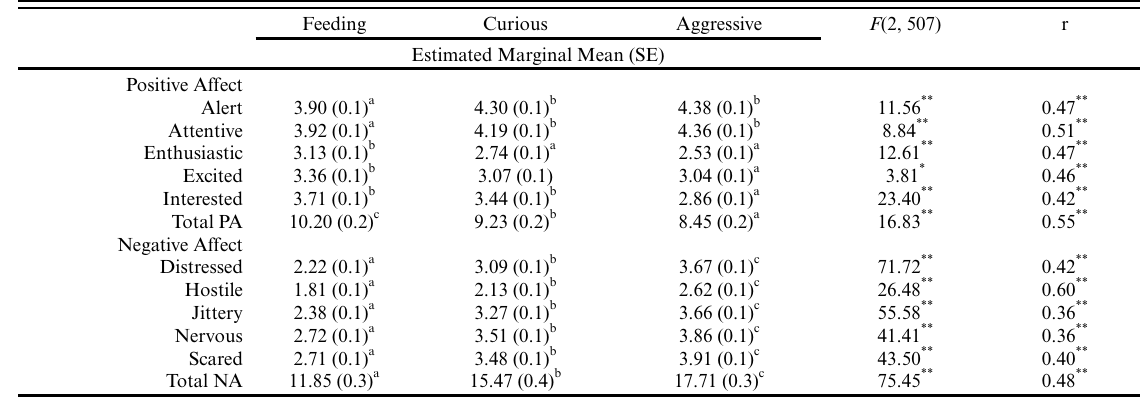
Table 2 . Estimated marginal mean for intensity of affective responses to the three behavior treatments. Note: Intensity was ranked by respondents on a five-point scale with one representing “very slightly or not at all” and five representing “extremely.” Superscripts represent significant differences across rows at the p < 0.05 level. The two-tailed Pearson correlation coefficient, r, represents the strength of the correlation between intensity of response for the behavior and setting videos. Total Positive Affect does not include alert or attentive. *p < 0.05, **p < 0.01.